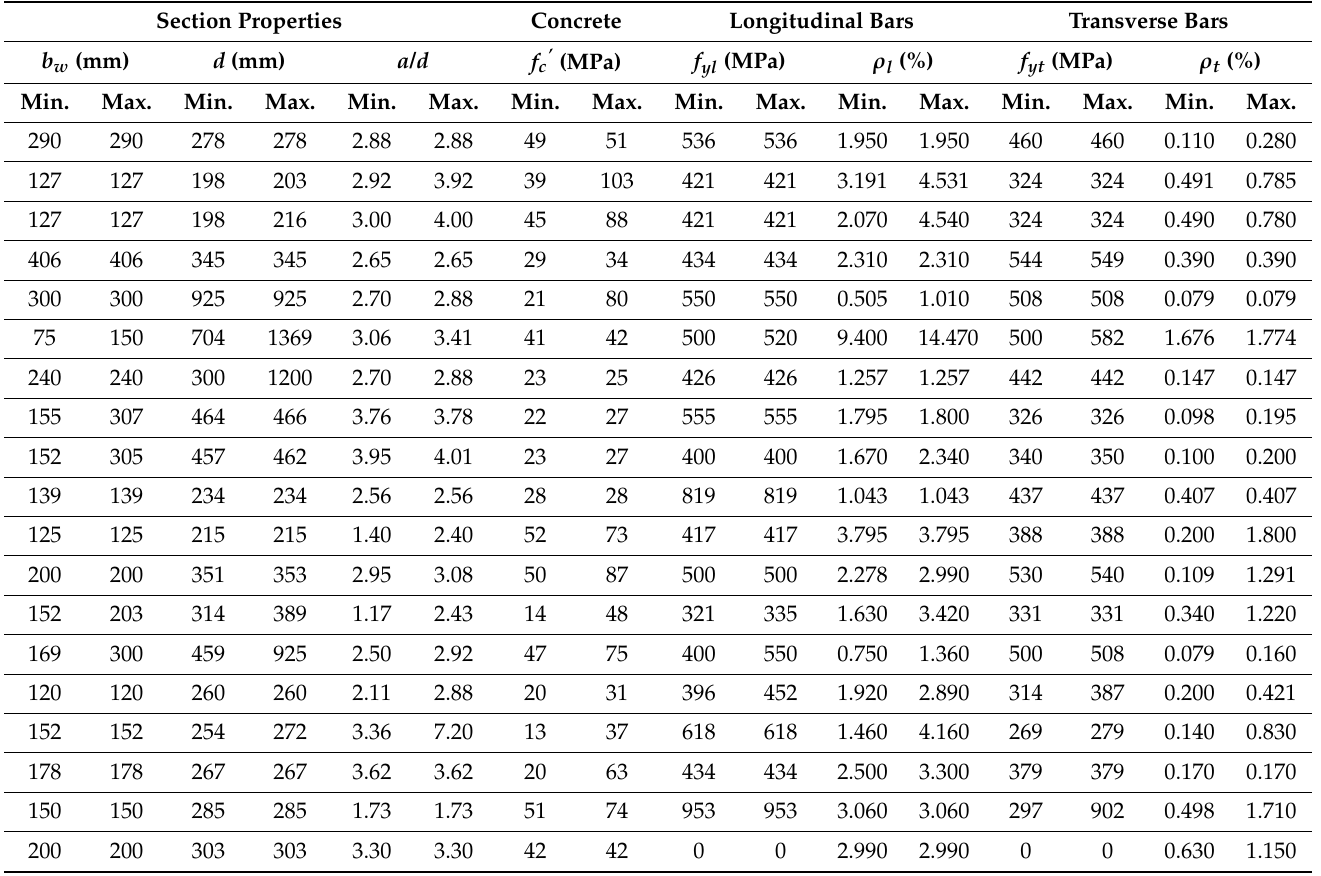
Table A1. Details of the training set